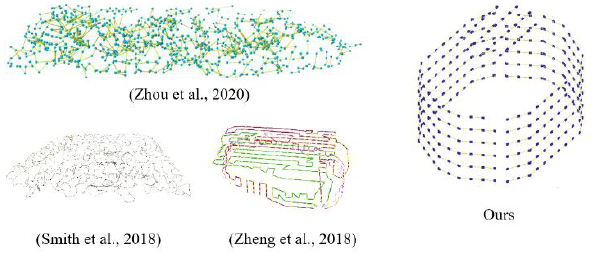
Figure 5 . Comparison of paths generated by different